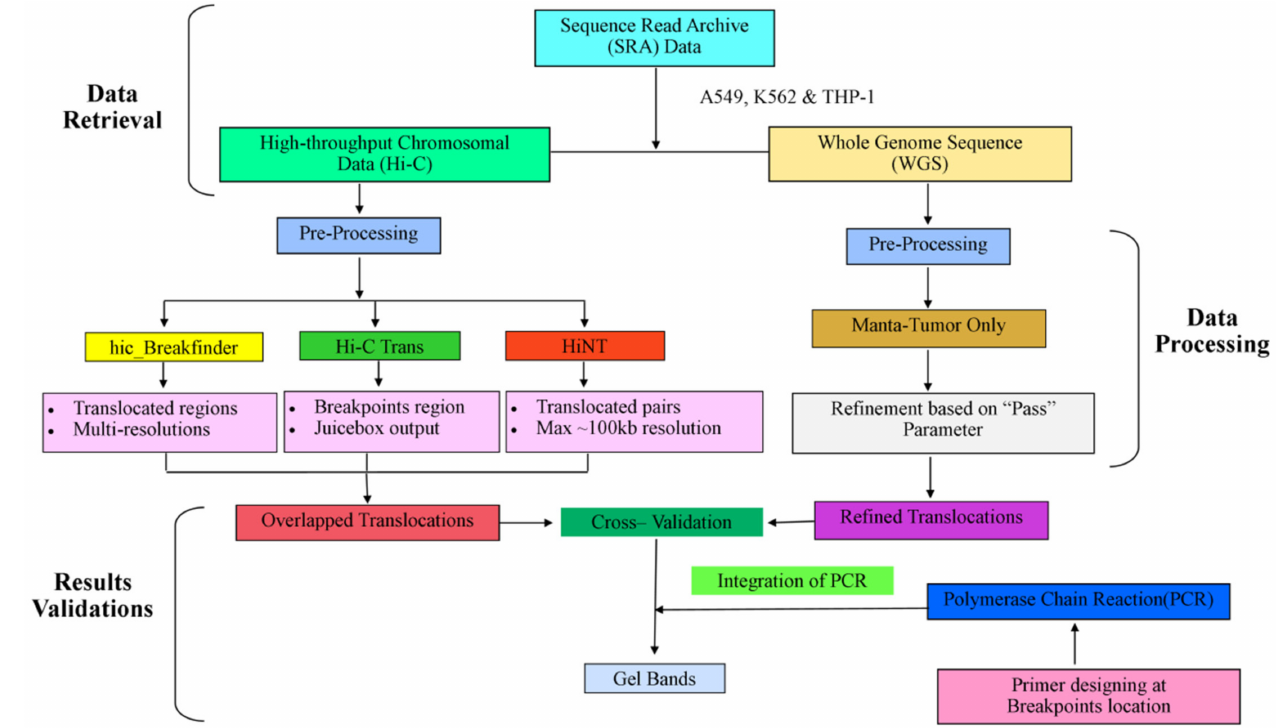
Figure 1. The complete workflow of data